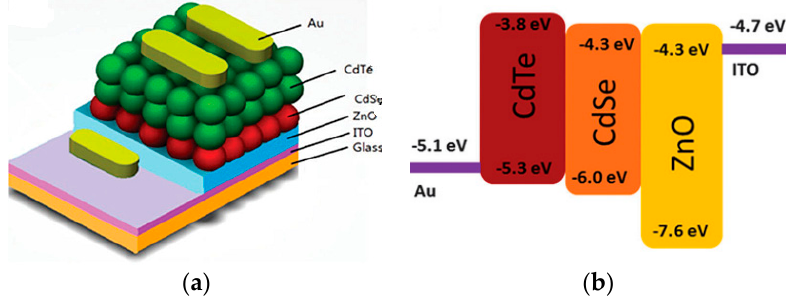
Figure 8. ( a ) Schematic of the CdTe-CdSe NC solar cell devices and ( b ) energy diagram of the above device used in the study. Reproduced with permission from [60], Copyright 2015, Royal Society of Chemistry.